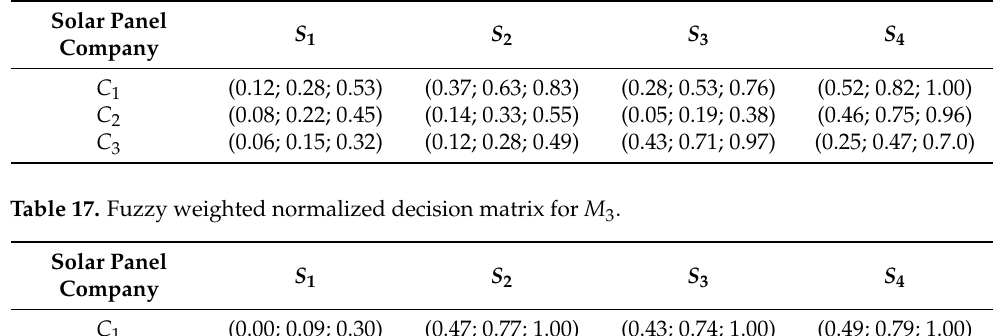
Table 16. Fuzzy weighted normalized decision matrix for M 2 . Solar Panel